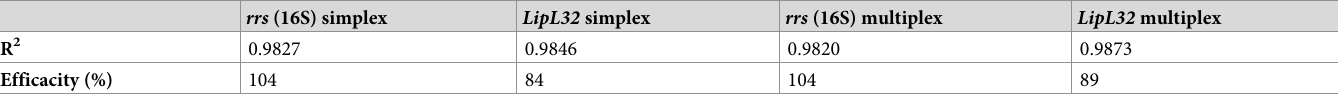
Table 2. Comparison of R 2 and efficiency between the simplex and multiplex qPCR assays developed in this study.